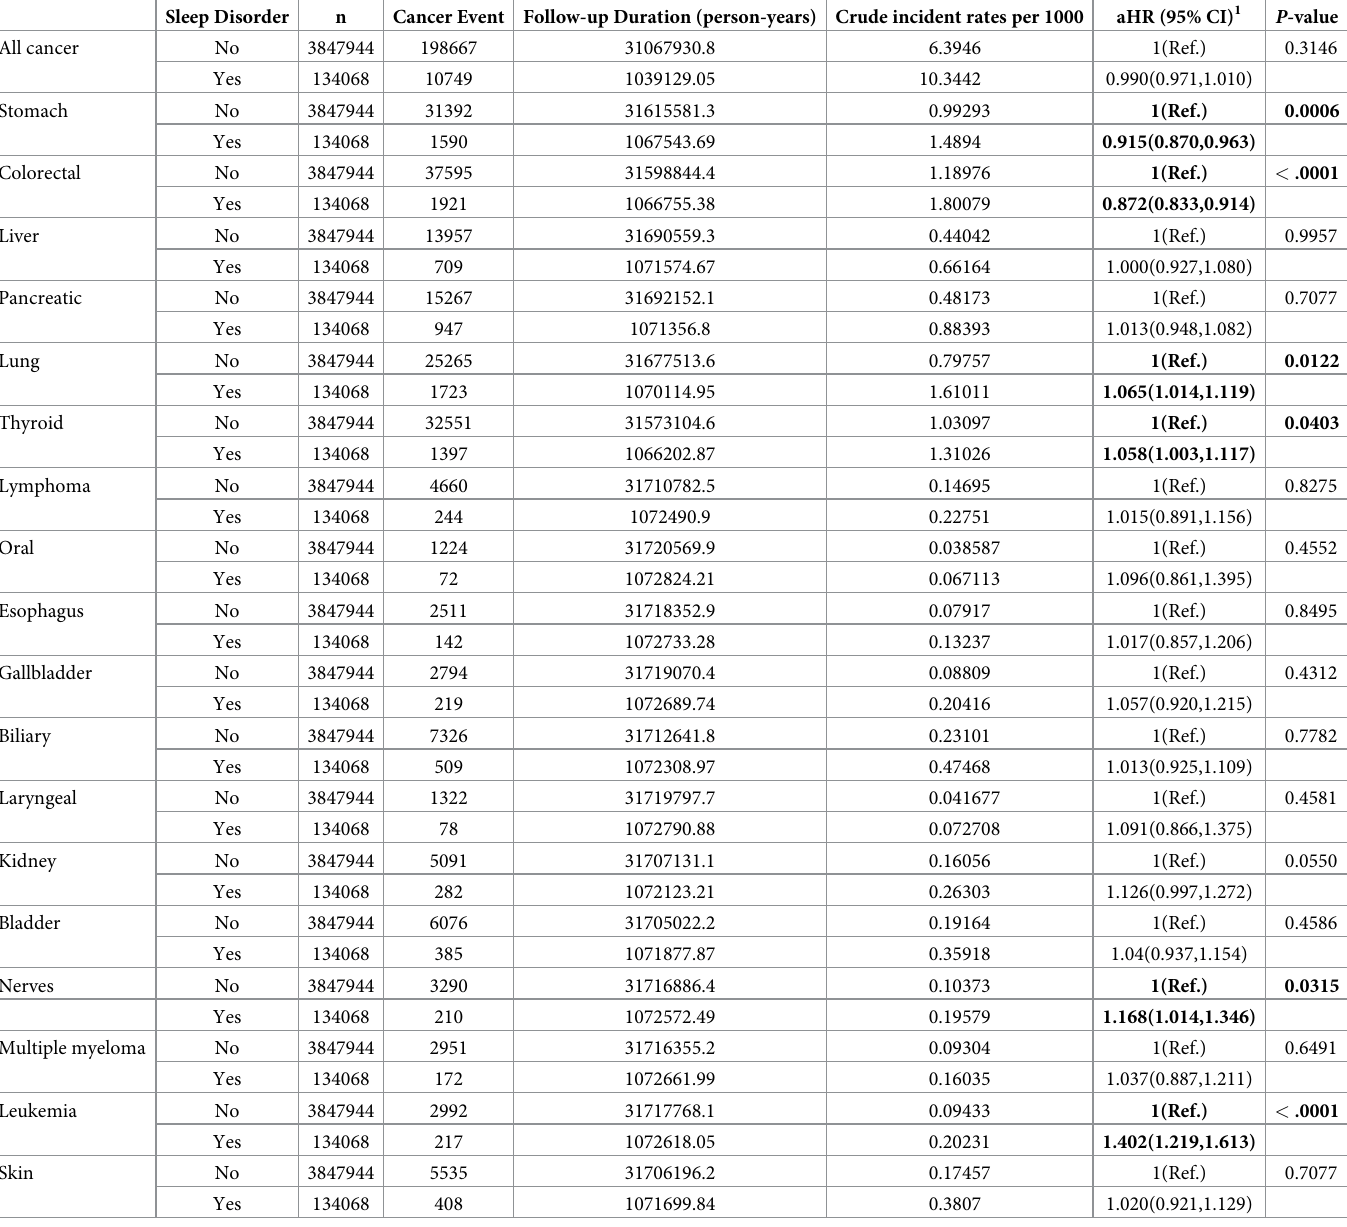
Table 2. Risk of cancers according to insomnia in the overall study